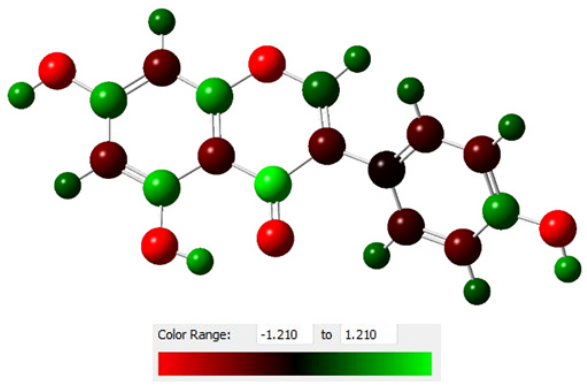
Fig. 8. The charge distribution of genistein . The red, black, and green loops show the high-electron, natural, and low-electron regions of genistein, respectively.